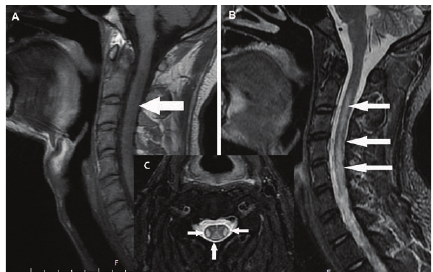
Figure 2: (A) T1-weighted MRI scans showing the dorsal spinal cord with hypointensity involving the posterior and lateral columns before treatment. (B) T2-weighted MRI scans showing the dorsal spinal cord with hyperintensity involving the posterior and lateral columns before treatment. (C) Transverse T2-weighted MRI scan of the cervical spinal cord at the C3 level demonstrating bilateral symmetric signal intensity within the dorsal and lateral columns (inverted V sign) before